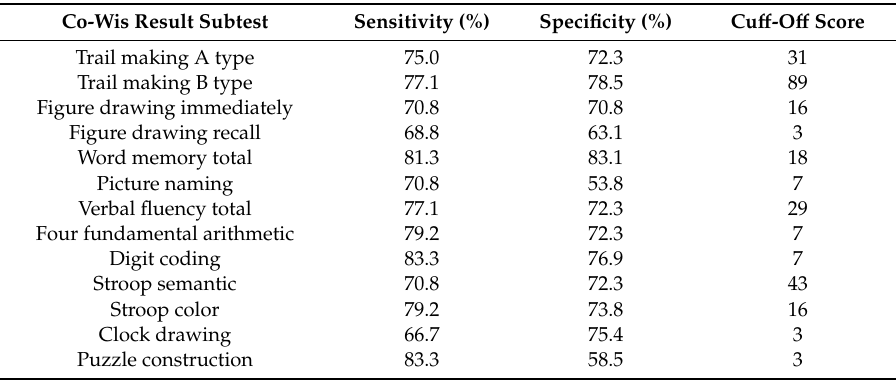
Table 9. Sensitivity and specificity of